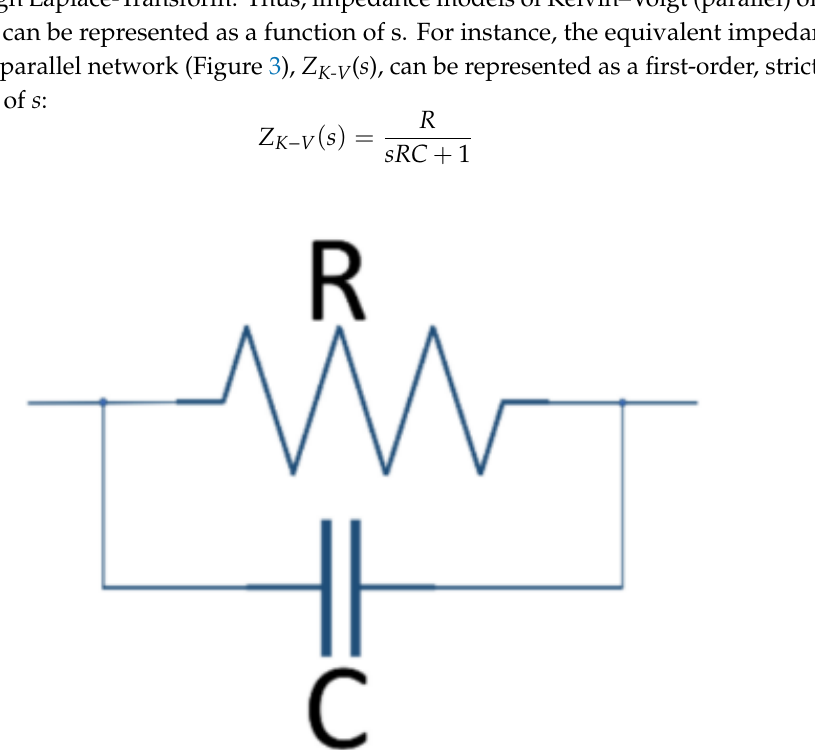
Figure 3. R-C parallel (Kelvin–Voigt type) model.